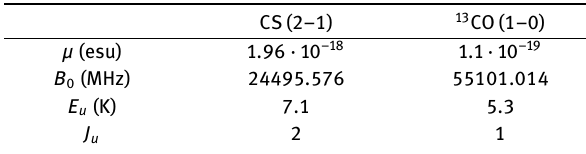
Table 1. Constants for CS(2–1) and 13 CO(1–0) column density calcu- lations from